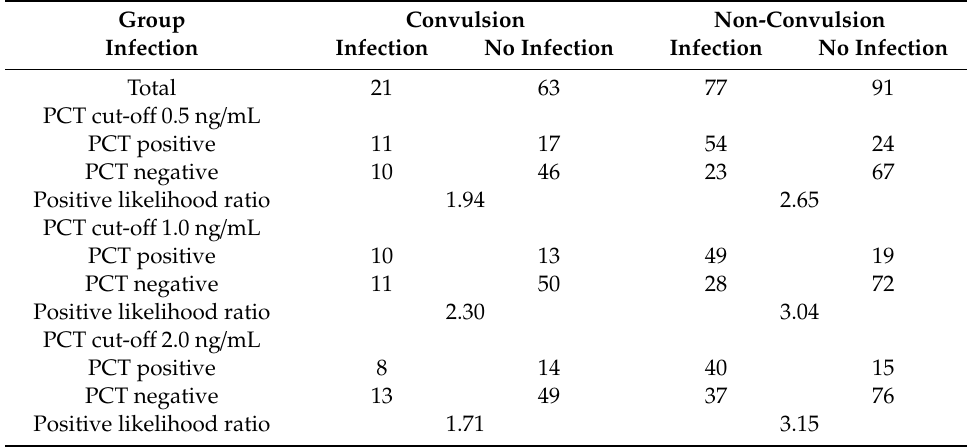
Table 2. Procalcitonin results and positive likelihood ratio for bacterial infection in two groups (convulsion and non-convulsion groups) when setting the three PCT cut-o ff values. Group Convulsion Non-Convulsion Infection